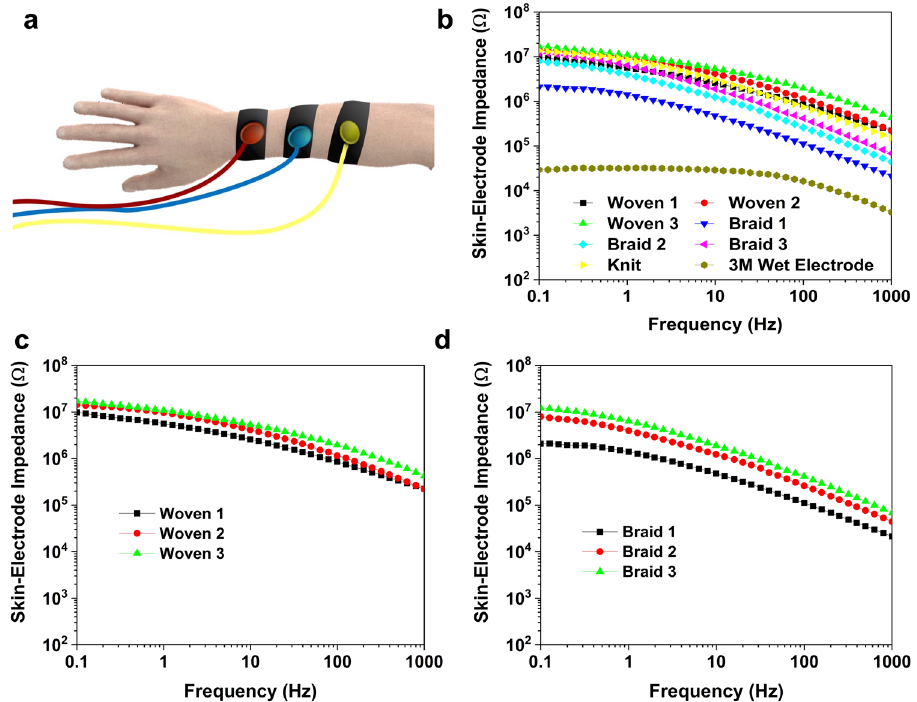
Fig. 3 Impedance Analysis of CNT Textile Electrodes. a Electrode placement for impedance measurements. b Impedance characteristics of CNT textile electrodes compared to commercial wet electrodes. Impedance variations against different size of c woven electrodes (CNT – Cotton – TPU yarn is in weft direction and neat cotton in warp direction. The electrode contains equal number of CNT-Cotton-TPU and neat cotton yarn per unit area. The electrode size decreases from Woven 1 to Woven 3. d braided electrodes contains all CNT – Spandex – TPU yarn intertwined together. The electrode size decreases from Braid 1 to Braid